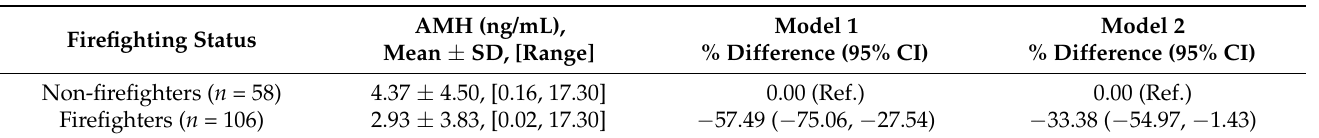
Table 3. Percent change in anti-müllerian hormone levels comparing non-firefighters and firefighters ( n =